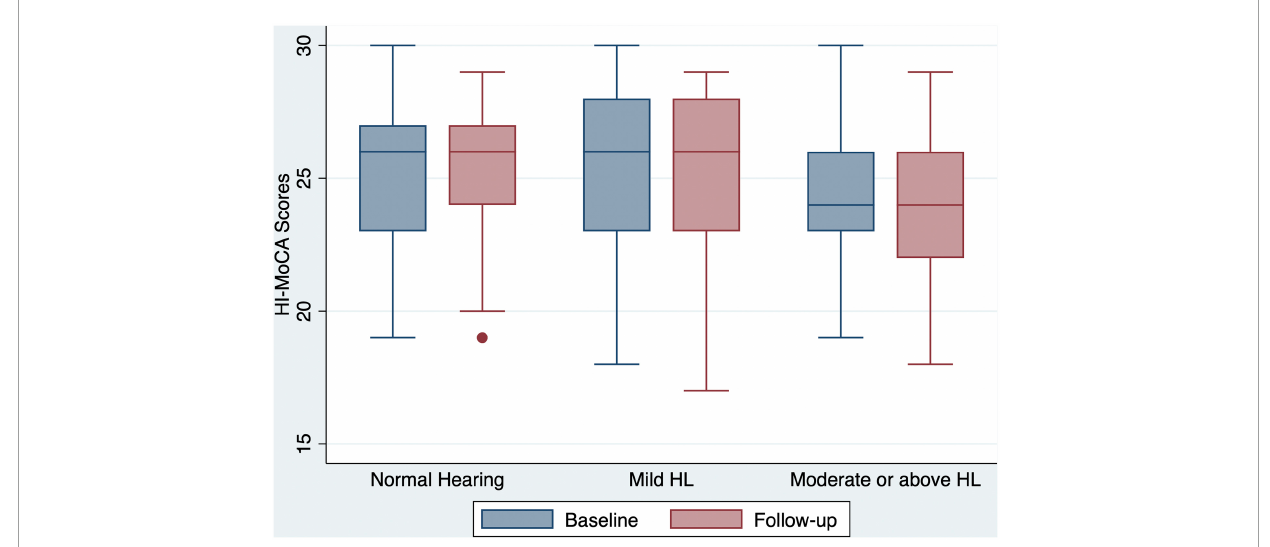
FIGURE1 Box and whisker plot of HI-MoCA scores and quartiles at baseline and follow-up, according to the HL categories. One outlier for a participant with normal hearing at follow-up is shown by a dot. HI-MoCA, hearing impaired-Montreal cognitive assessment; HL, hearing loss.